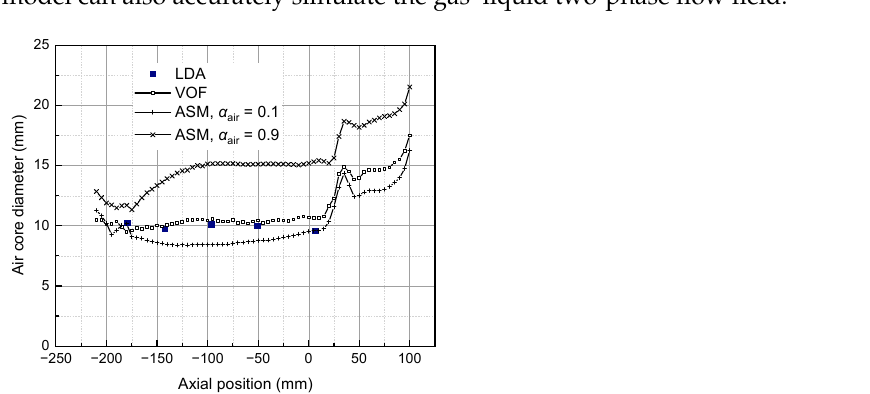
Figure 4. Comparison of air core diameters obtained from numerical tests and LDA measure- ments.